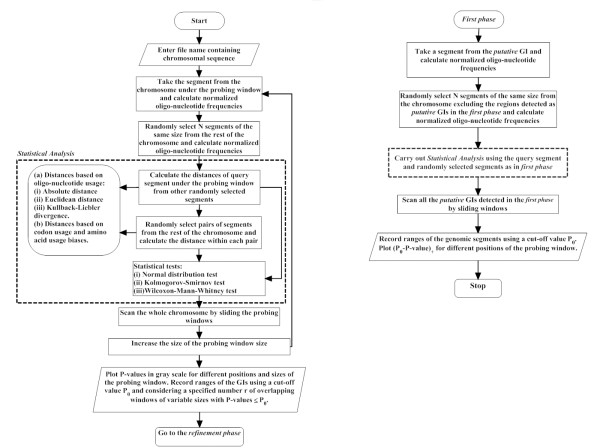
Algorithmic flow-charts of the first phase (Fig. 1A) and the refinement phase (Fig. 1B) of Design-Island.